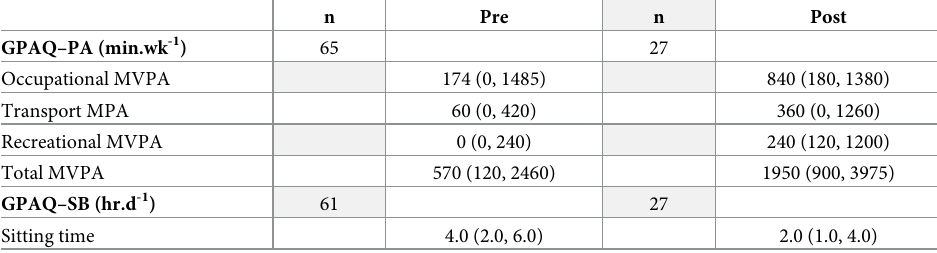
Table 10. Pre- and post-programme self-reported physical activity and sedentary behaviour (total sample) � . n Pre n